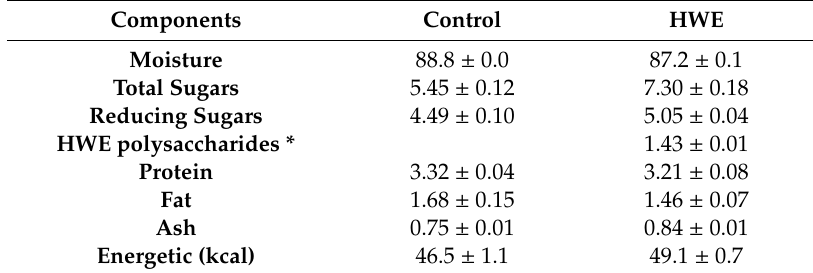
Table 4. Nutritional composition expressed as g / 100 g of fresh weight control and supplemented yogurt with apple pomace